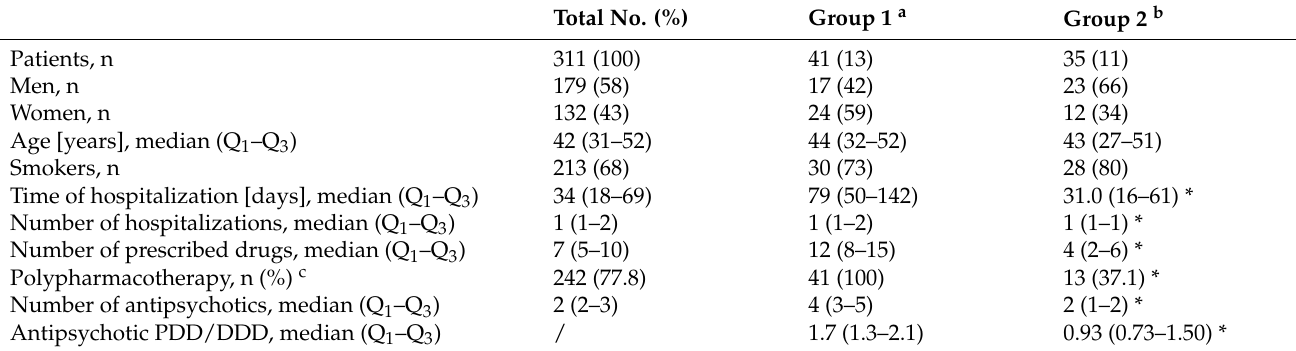
Table 1. Characteristics of